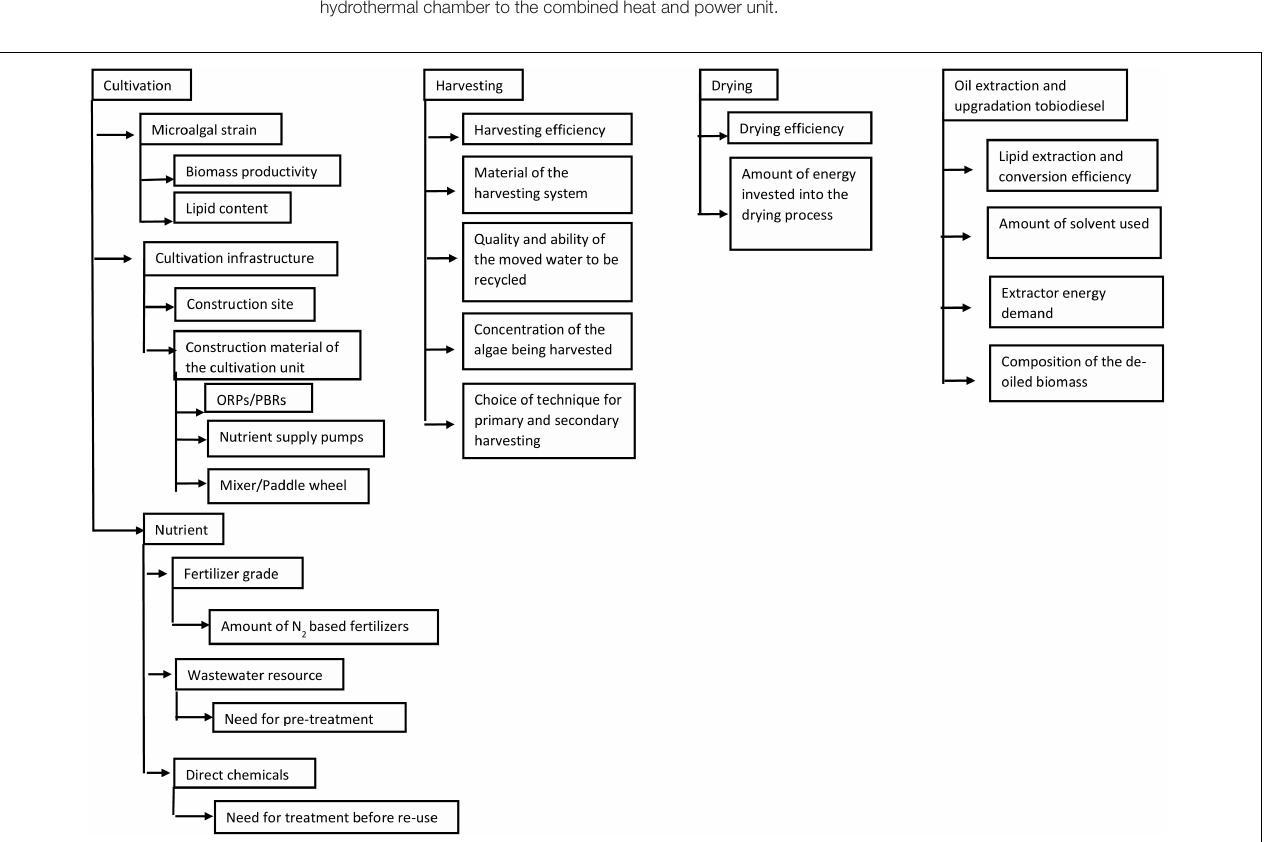
FIGURE 2 | Factors influencing the GHG emissions from the microalgal biodiesel production